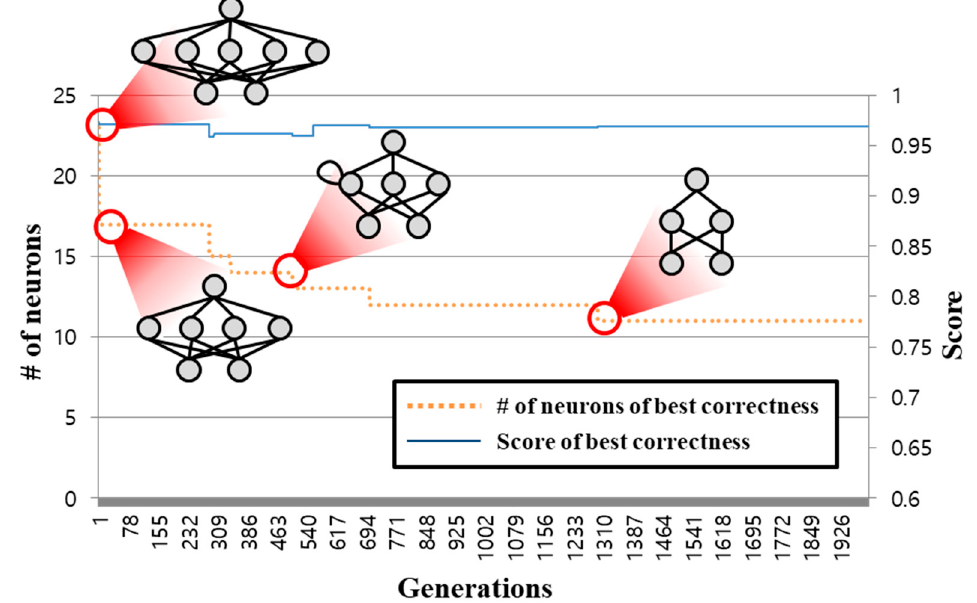
Figure 7. Simulation result of second simulation.